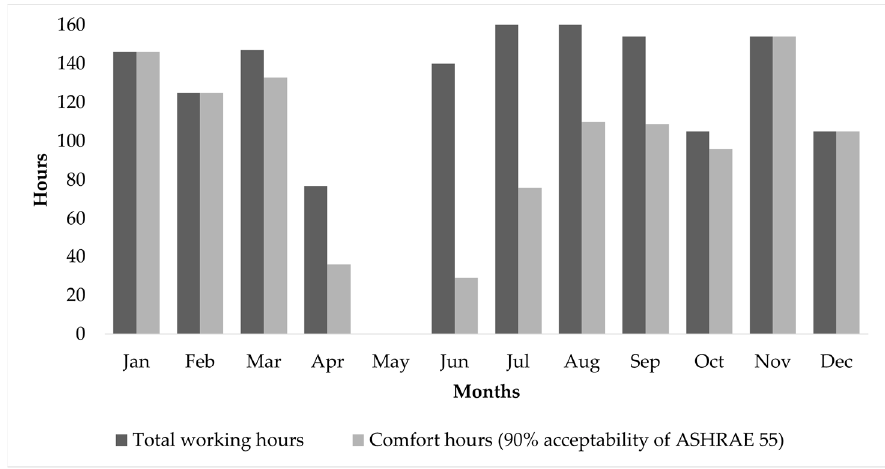
Figure 5. Number of comfortable working hours per month.